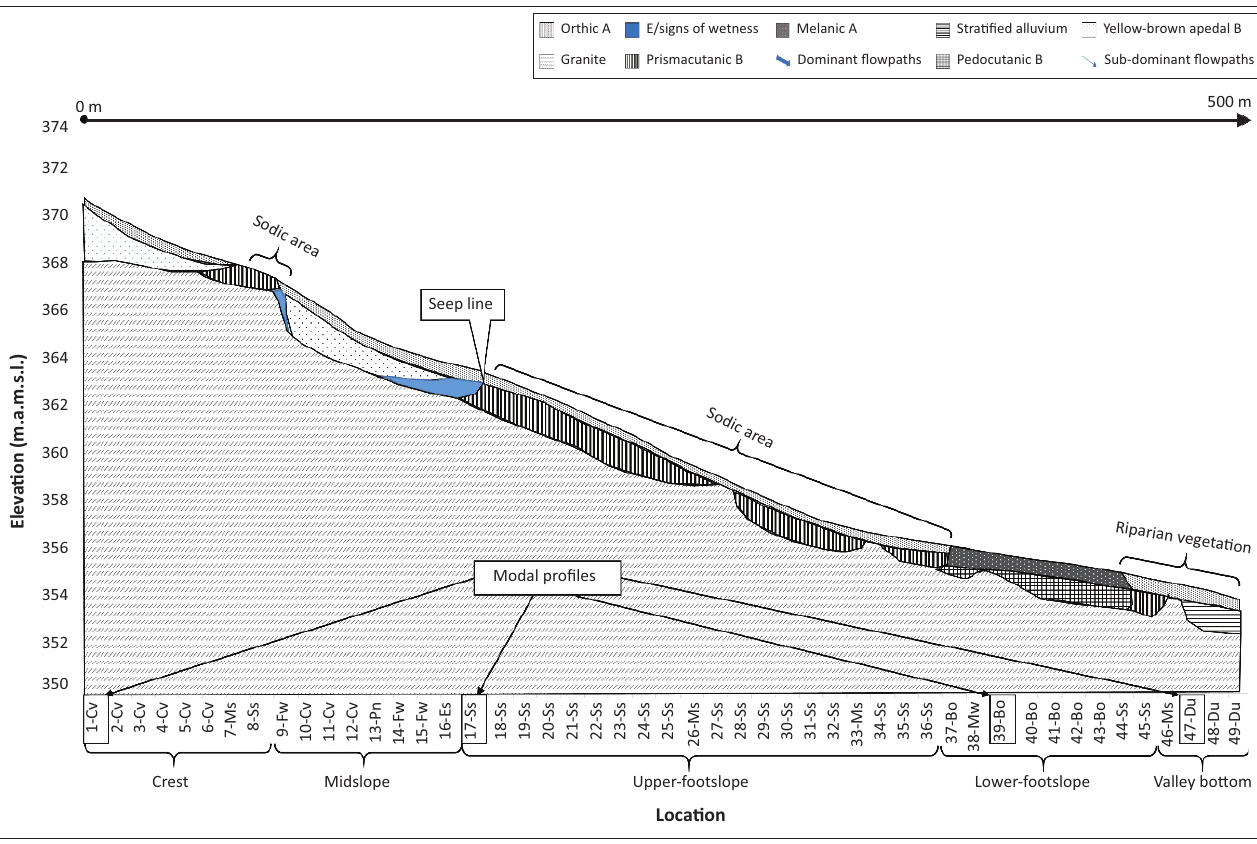
FIGURE 2: Soil distribution pattern and location of observations, soil types and modal